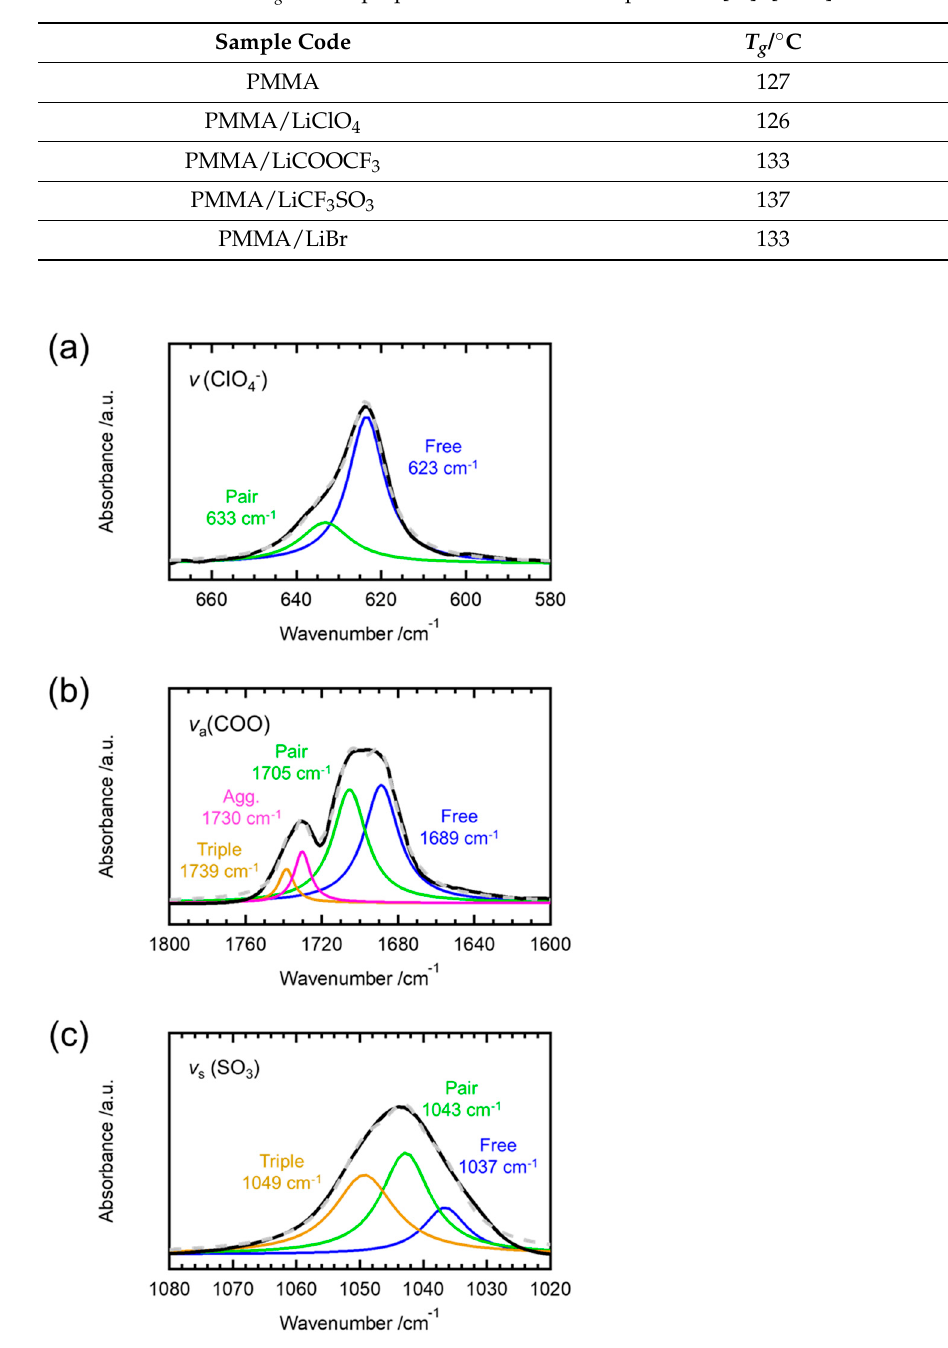
Table 1. The values of T g for the prepared PMMA/salt samples with [Li]/[C=O] = 0.07.